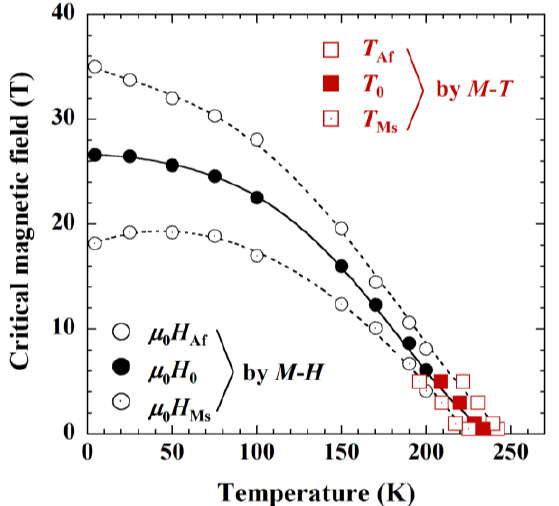
Figure 4. Temperature dependence of the field-induced reverse martensitic transformation finishing field, μ 0 H Af , martensitic transformation starting field, μ 0 H Ms , and equilibrium martensitic transformation field, μ 0 H 0 (≡ (μ 0 H Af + μ 0 H Ms )/2), together with the reverse martensitic transformation finishing temperature, T Af , martensitic transformation starting temperature, T Ms , and the equilibrium martensitic transformation